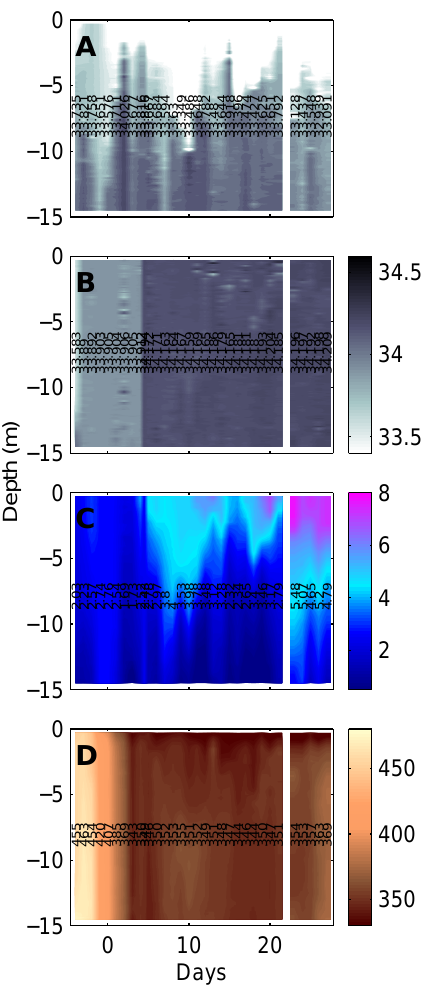
Fig. 5. Measured vertical distribution and change with time of salin- ity in the fjord (A) and mesocosm M1 (B) , together with those of temperature (C) and oxygen concentration (D) , reported in degrees celsius and µmolkg − 1 , respectively. Note that both vertical and temporal changes in salinity, temperature and oxygen were virtu- ally identical between mesocosms. Vertical numbers denote depth- averaged (0.3–12m) means of the respective parameter for each